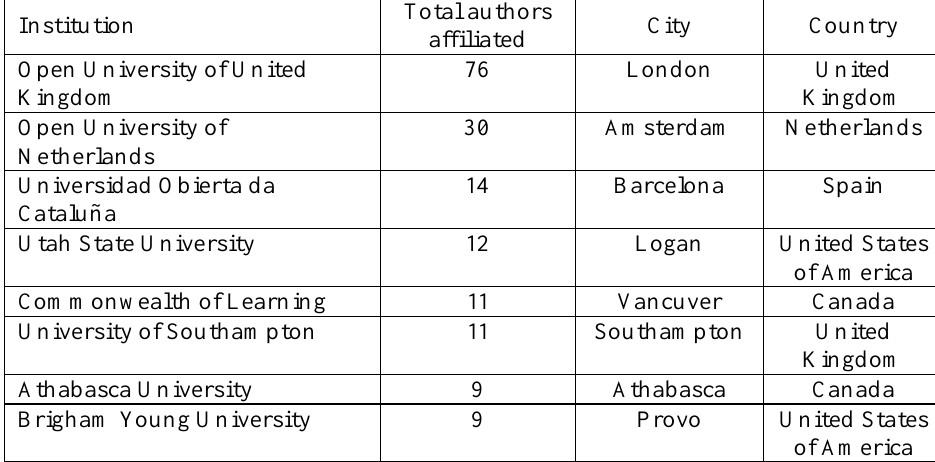
The Most Productive